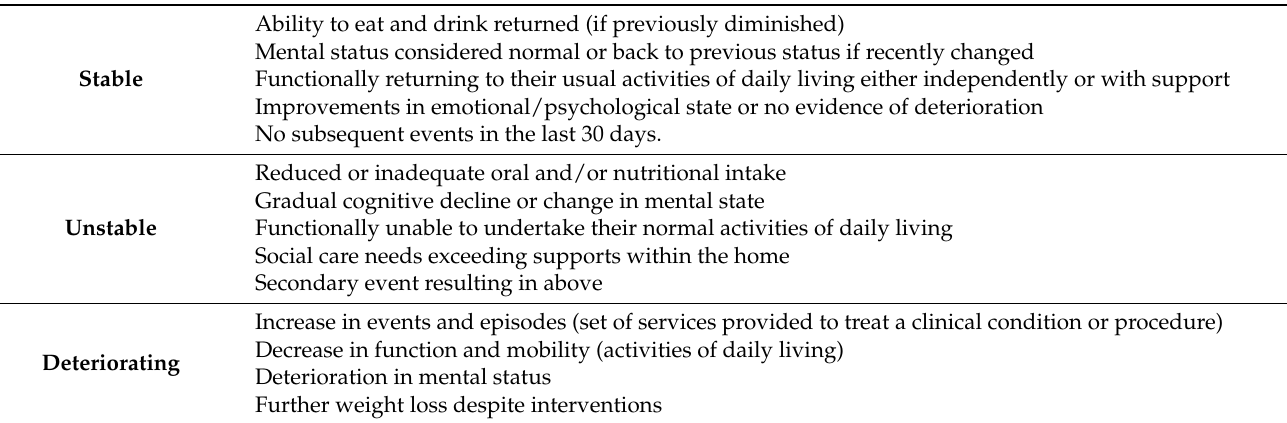
Table 1. Pre-defined ‘health states’ used to compare risk scores at 60 and 90 days with baseline, after admission to the Community Virtual